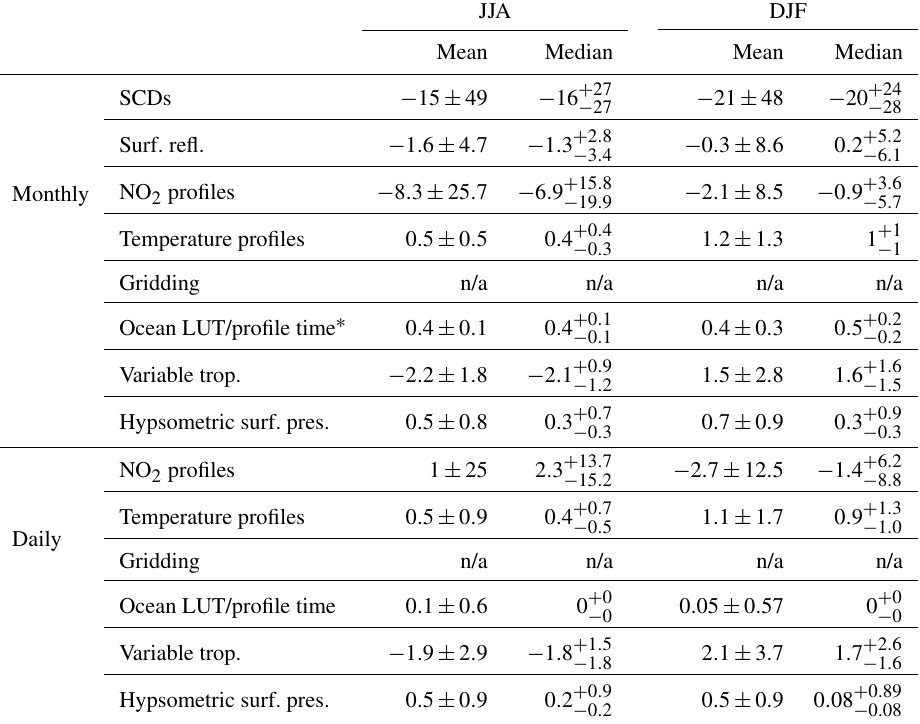
Table 4. Percent differences in individual pixels’ NO 2 VCDs for each increment. Means are given with 1 σ uncertainties; medians are given with uncertainties as the distance to the upper and lower quartiles. “Monthly” and “Daily” in the first column indicate which subproduct is considered (Sect. 2.6). “Ocean LUT” refers to the ocean surface reflectance LUT. Outliers were removed before calculating these statistics. JJA